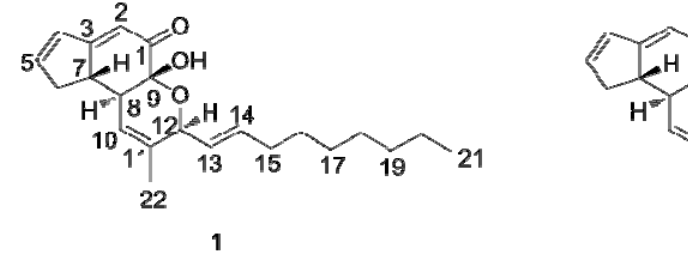
Figure 1. The structures of compounds 1 – 4